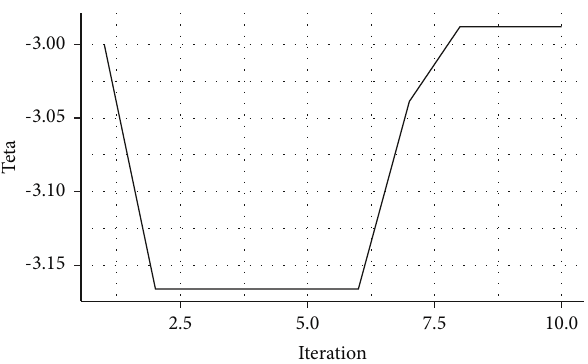
Figure 2: θ estimation process.